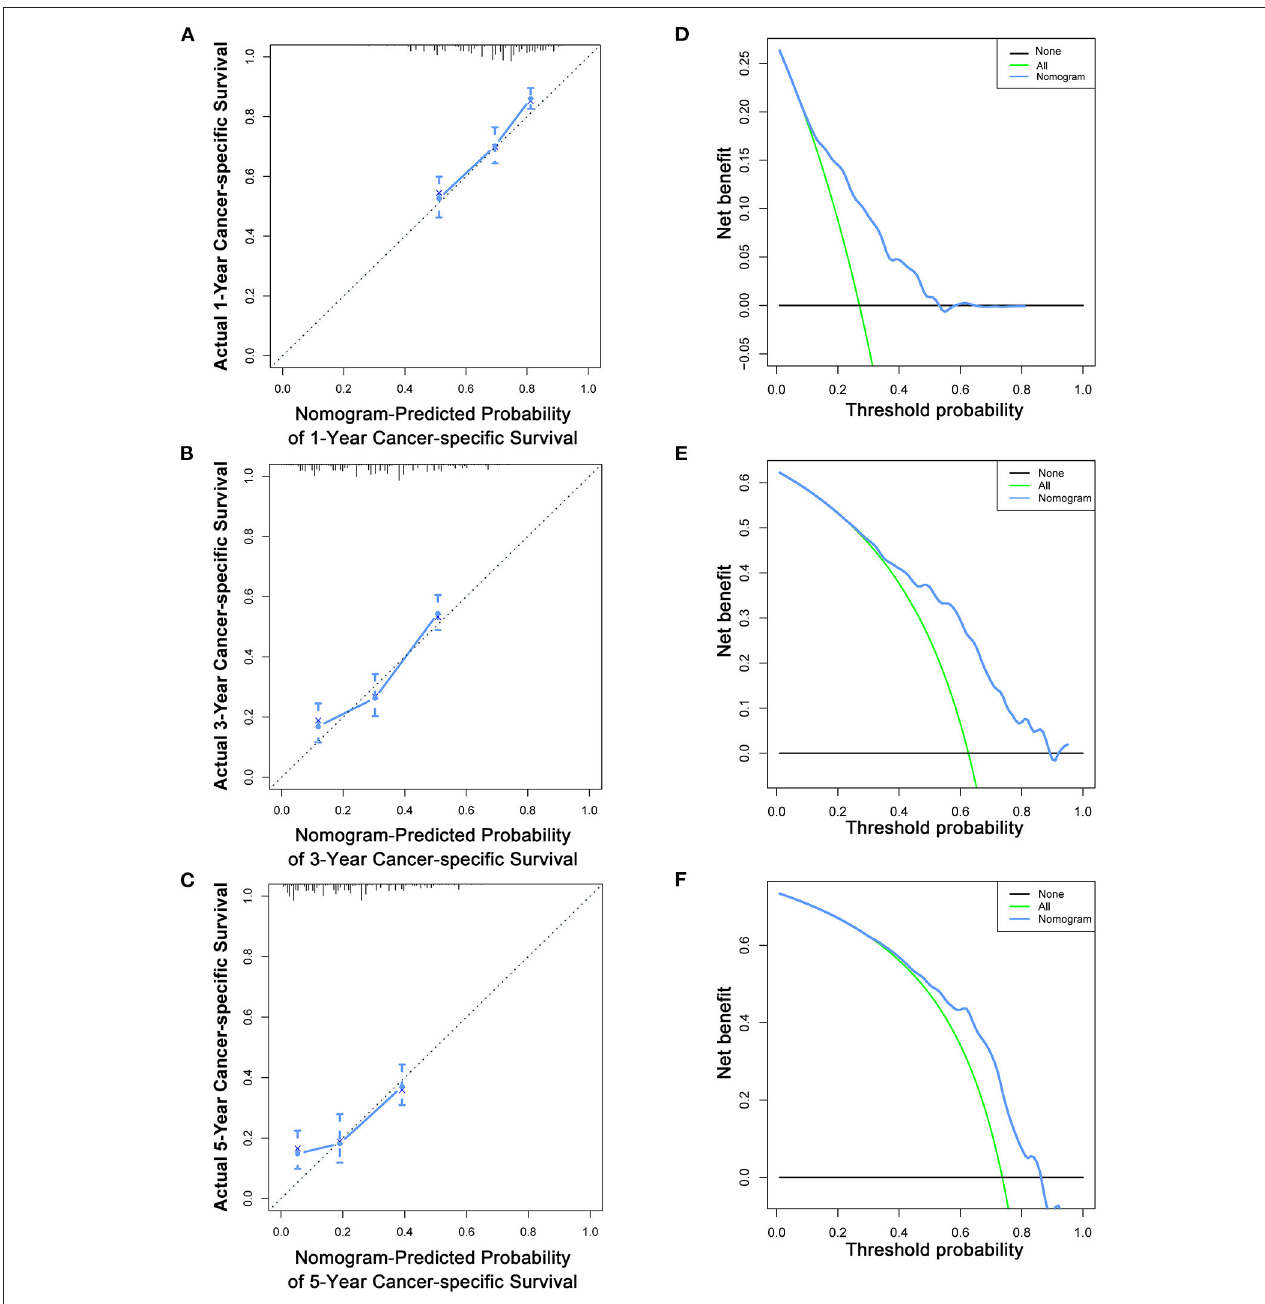
FIGURE 6 | Calibration curves (A–C) and DCA (D–F) of the nomogram for predicting patients’ CSS at 1, 3, and 5 years in the training